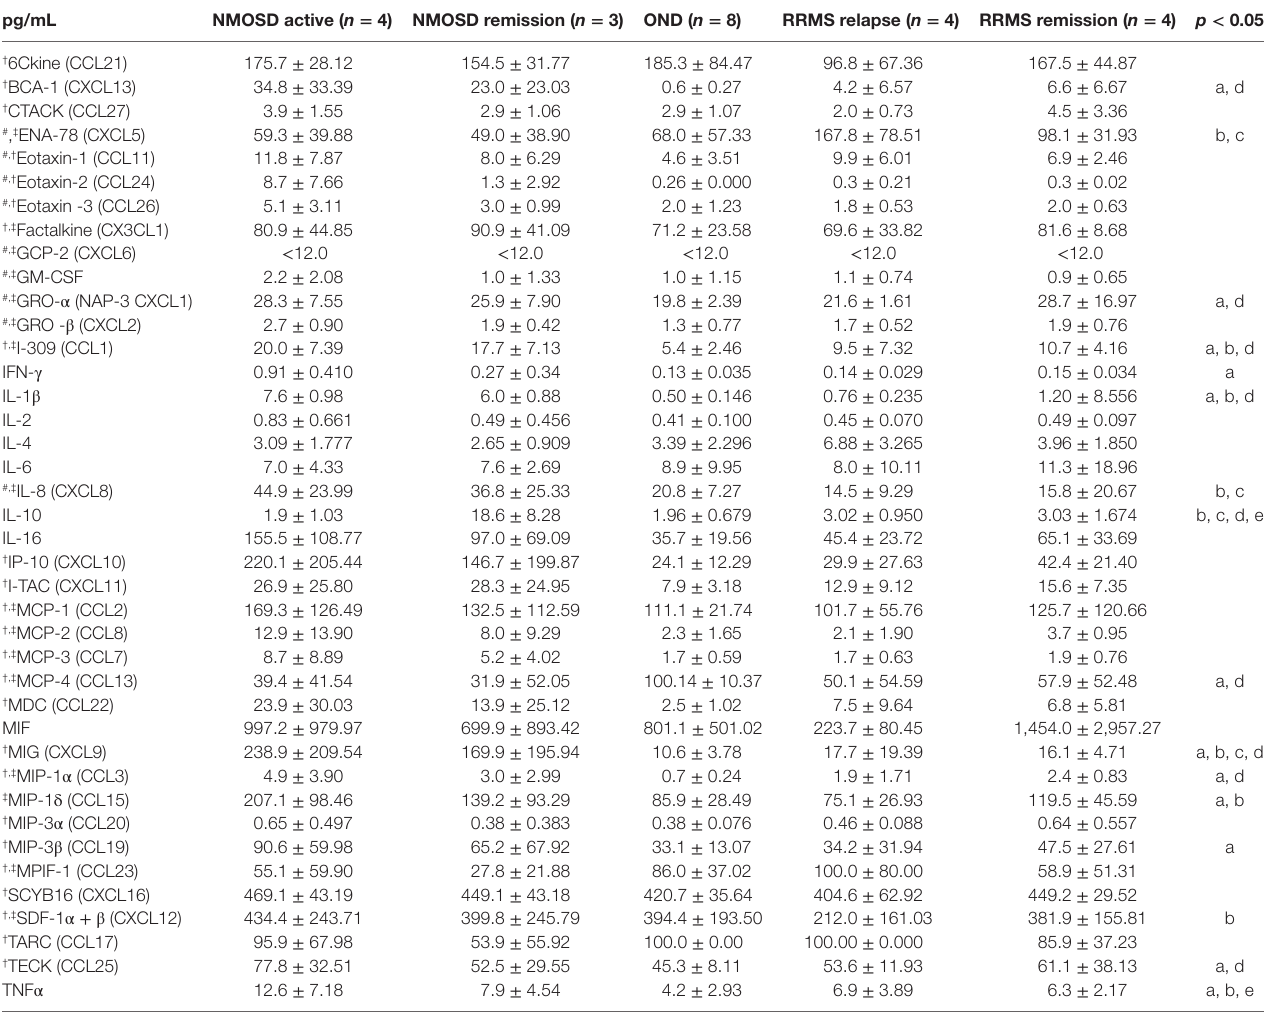
Table 1 | Cerebrospinal fluid (CSF) chemokine and cytokine concentrations in the patients with neuromyelitis optica spectrum disorder (NMOSD), remitting–relapsing multiple sclerosis (RRMS), and other neurological disorders (OND) (mean ± SD).